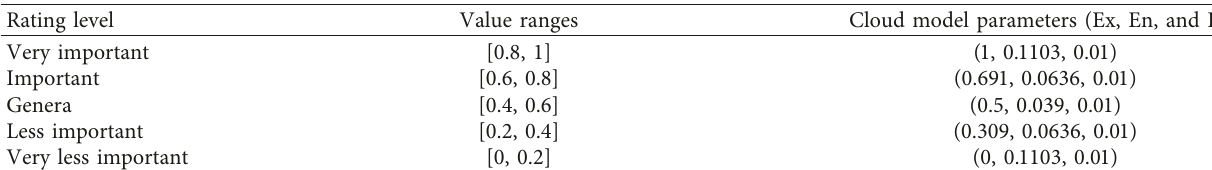
Table 3: Rating level and cloud model